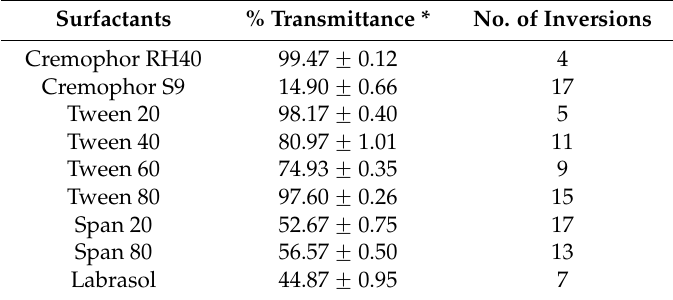
Table 2. Emulsification Efficiency of Various Surfactants.